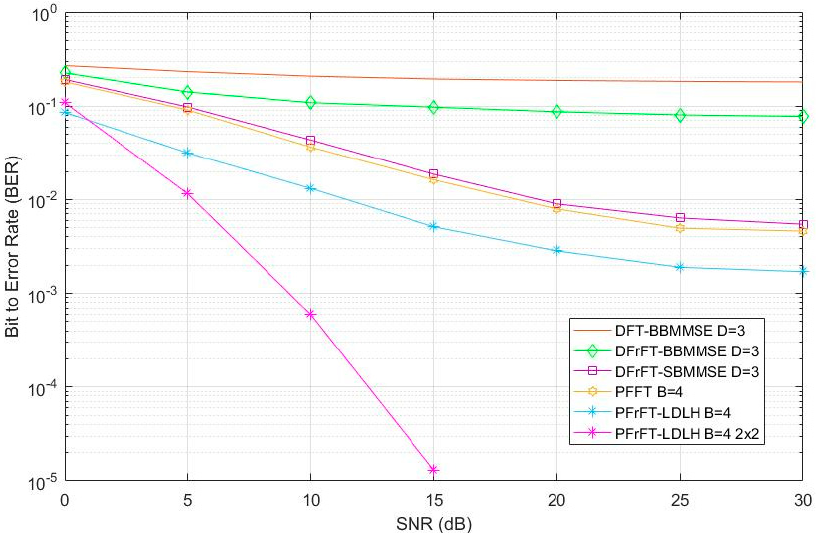
Figure 9. BER performance of various